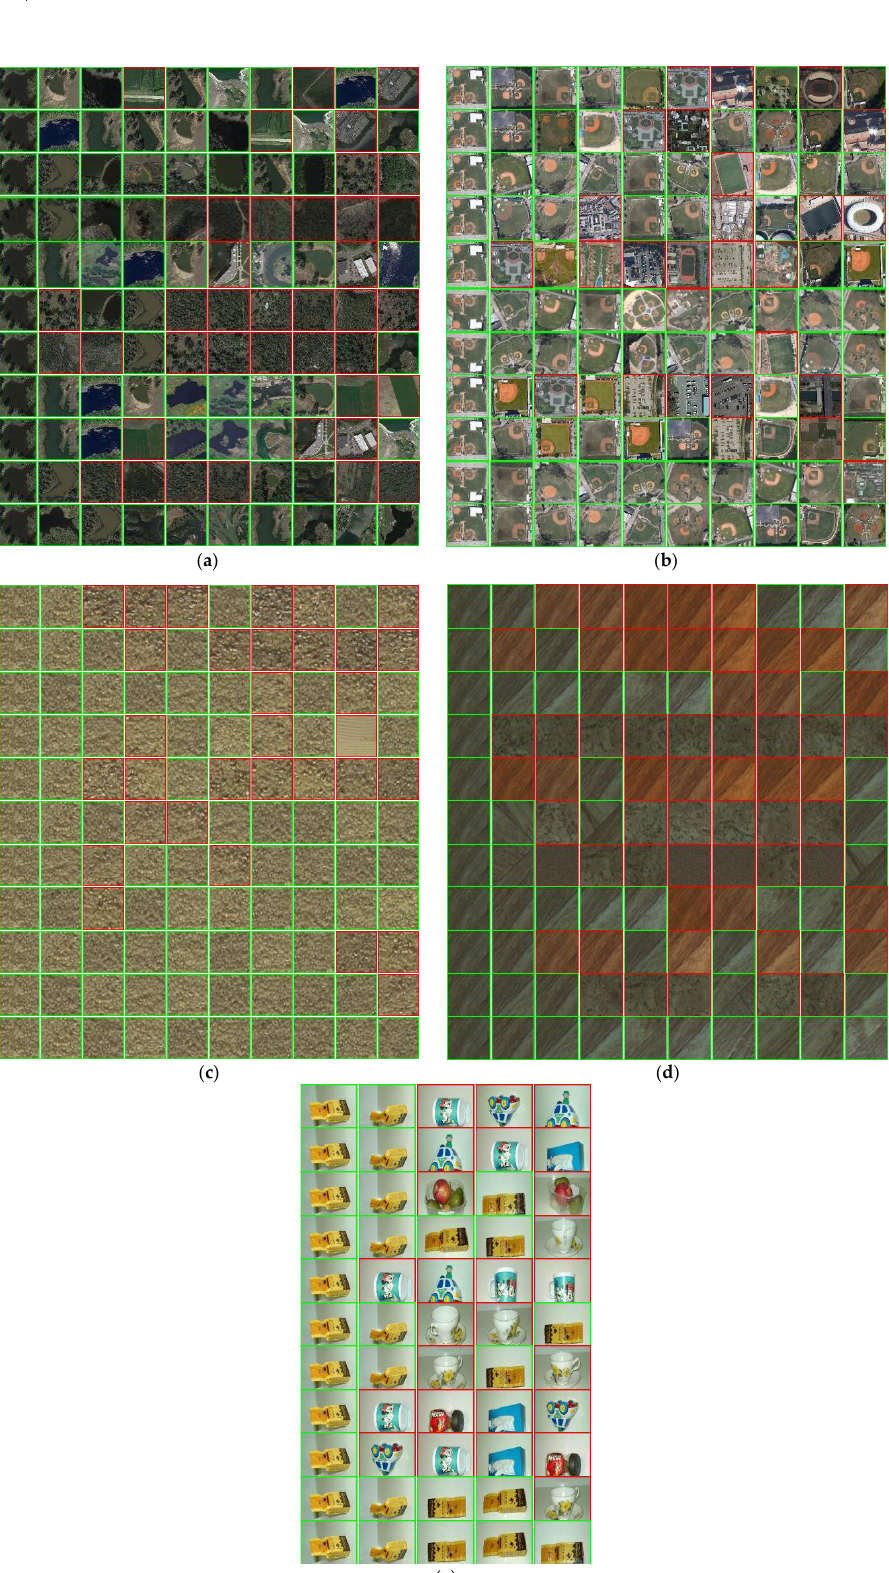
Figure 7. Results of the top-10 retrieved images by considering different query images: ( a ) “River Lake” ; ( b ) “Baseball Field” ; ( c ) “Rice”; ( d ) “Carpet”; and ( e ) “Paper Bag” using different descriptors (Row 1 using mdLBP, Row 2 using maLBP, Row 3 using CDH, Row 4 using MSD, Row 5 using LNDP + LBP, Row 6 using MPEG-CED, Row 7 using Joint Colorhist, Row 8 using OCLBP , and Row 9 using IOCLBP, Row 10 using PUH + MCM and Row 11 using